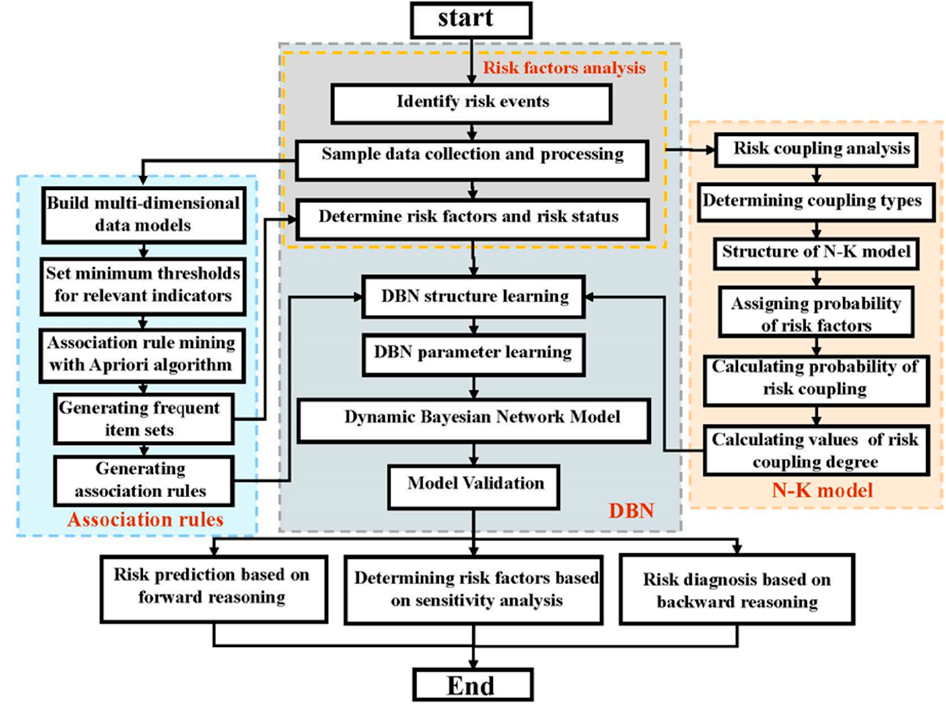
Figure 2. Framework of the dynamic and quantitative risk assessment based on the N–K model, ARM, and DBNs. ARM, and